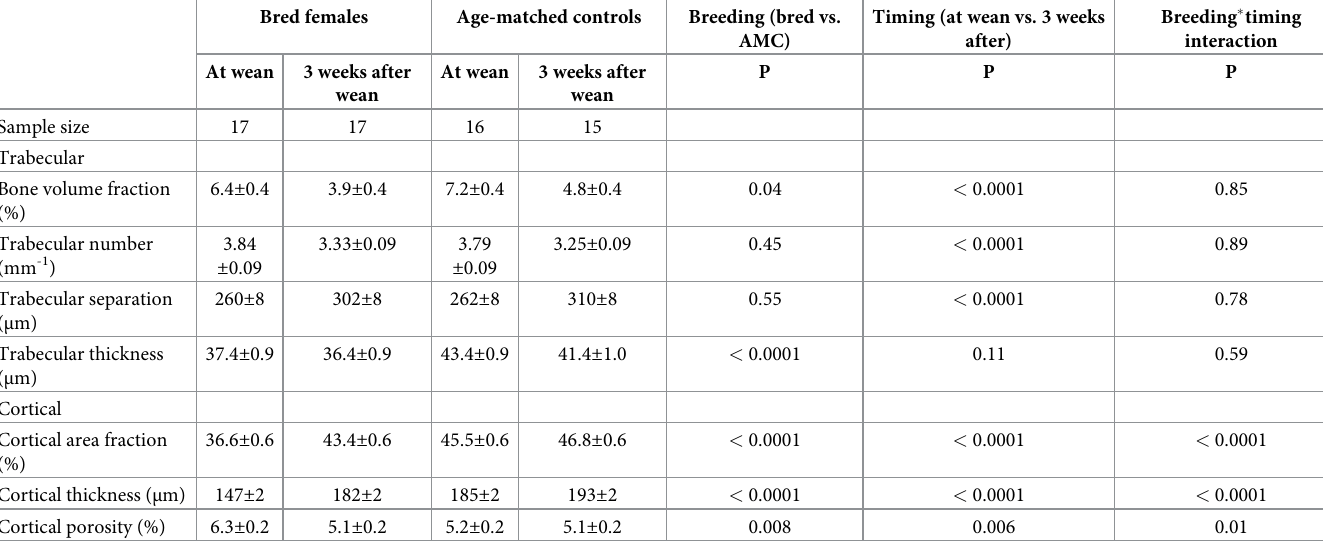
Table 1. Effects of lactation and recovery after weaning on skeletal traits in 2 month old control mice.